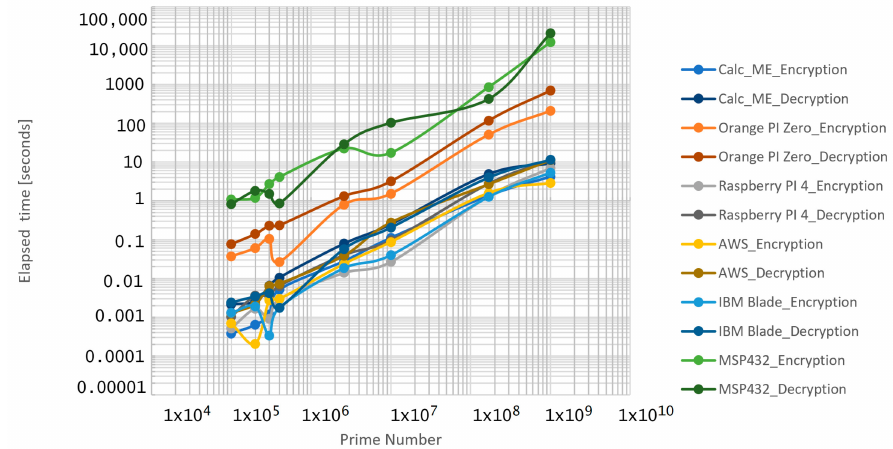
Figure 11. Encryption/decryption elapsed times for three entities in the